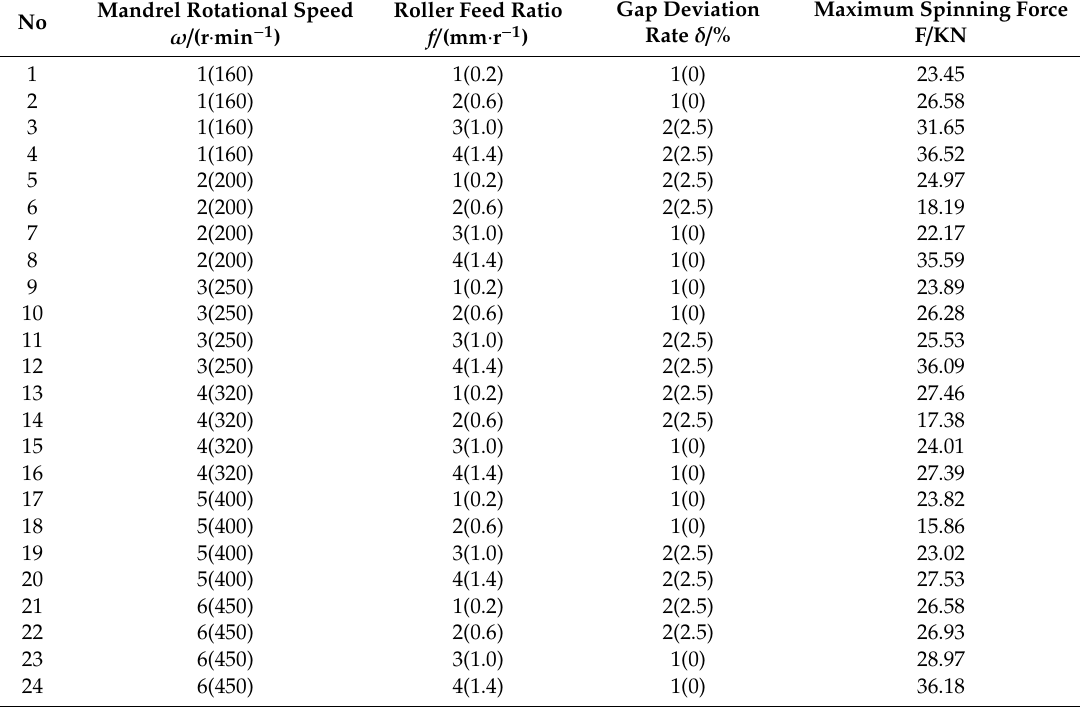
Table 2. Test plans and results of the